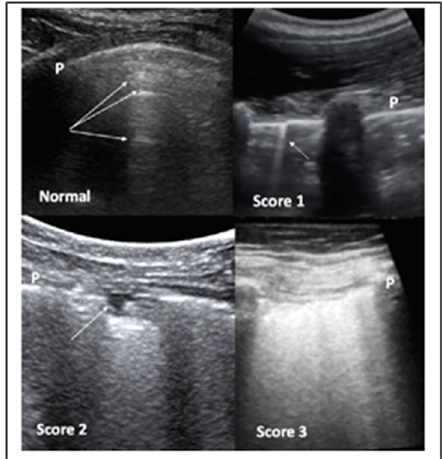
Figure 3. LUS aspects of COVID-19 pneumonia. Top left panel—LUS in normal cases. The pleura line (P) is sliding, mobile at breathing, and hyperechoic. The arrows indicate the A lines, which are horizontal, not mobile lines below the pleura line. Top right panel—LUS in COVID-19 patient: the presence of irregularities of the pleura line (P) coupled with vertical, comet-like, mobile B lines (arrow) become apparent. These findings are frequently bilateral and alternate with areas of normality, as shown in this panel. Bottom left panel—LUS in COVID-19 patient: the pleura line P is broken. Subpleural triangular dark area (arrow) with a hyperechoic floor is defined a subpleural consolidation area. Bottom right panel—LUS in COVID-19 patient: the so-called “white lung”.